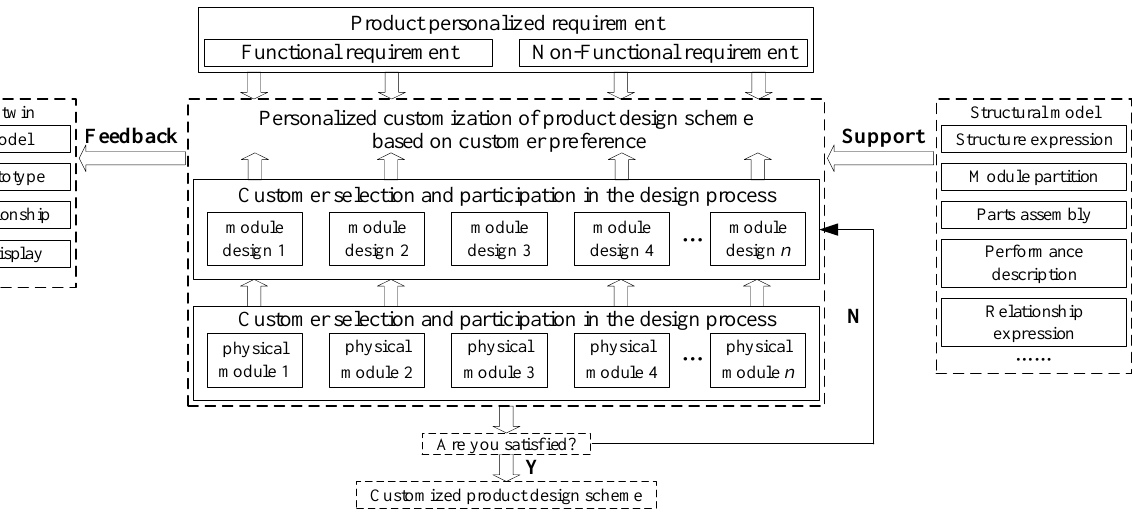
Figure 4. The decomposition form of the DMS-DT integration framework.